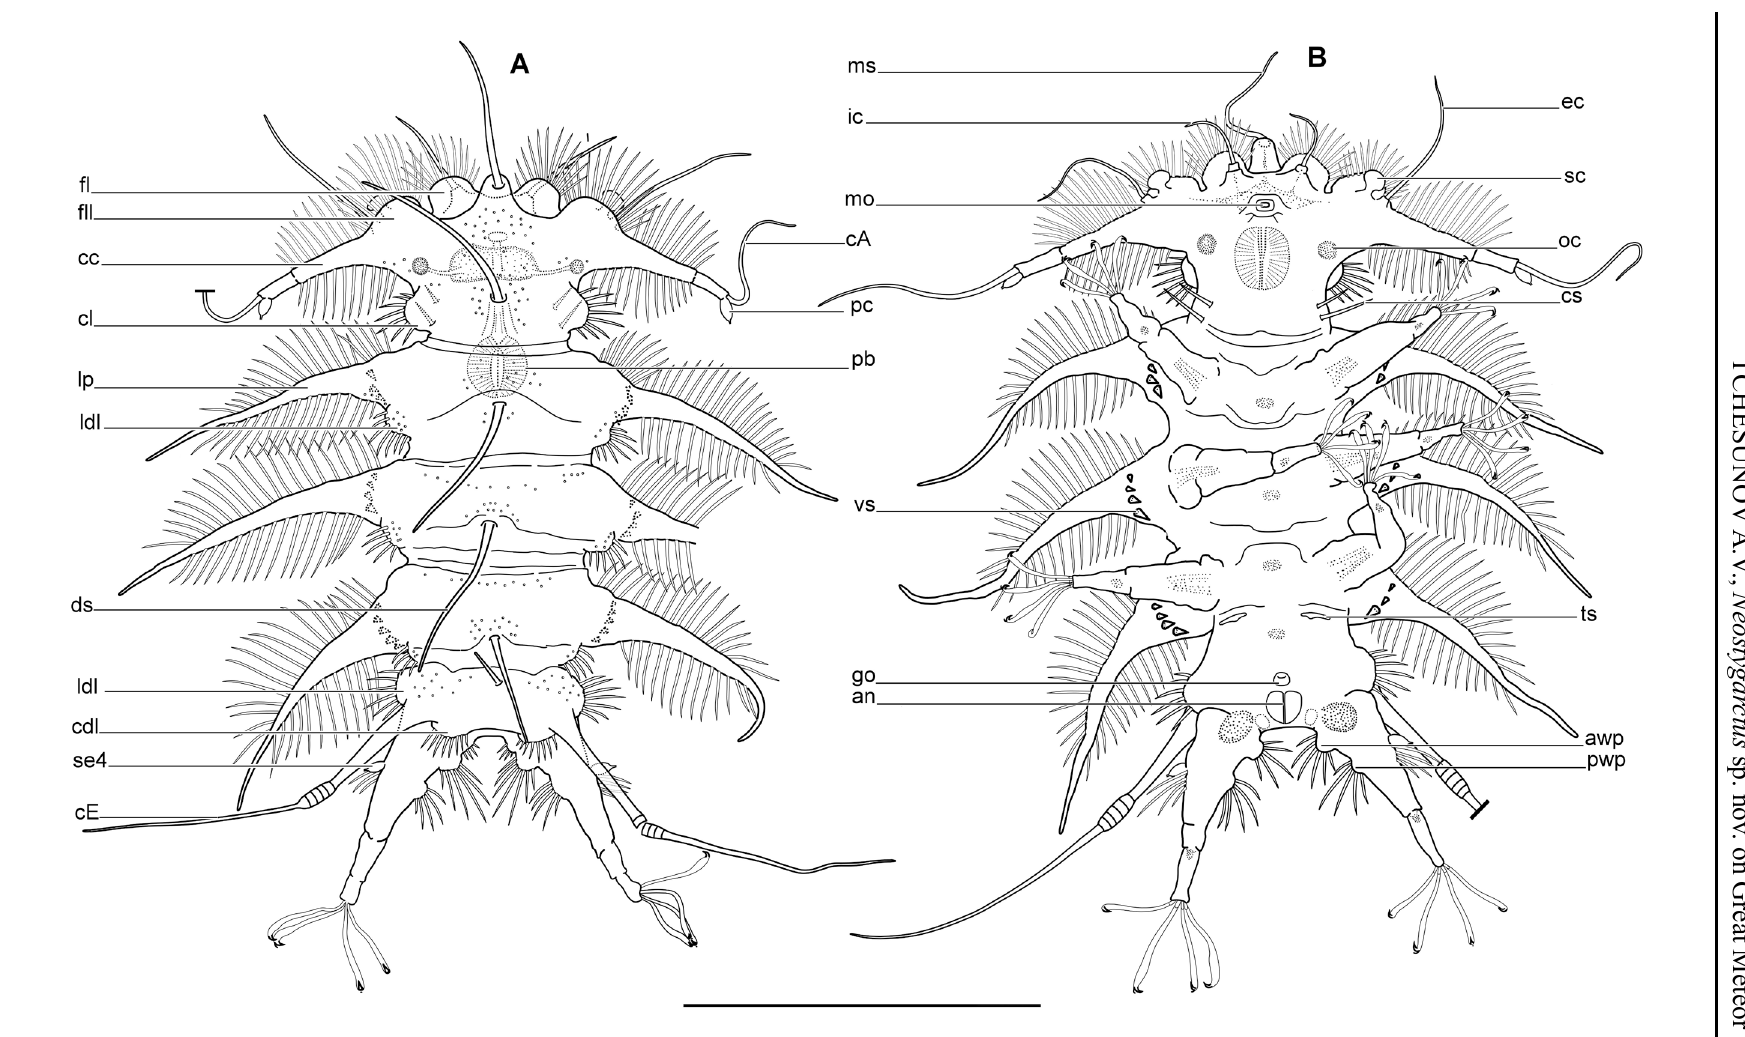
Fig. 2. Neostygarctus grossmeteori sp. nov., entire. A . Holotype, ♀ (SMF 51), dorsal view. B . Paratype, ♂ (SMF 58), ventral view. Scale bar = 100